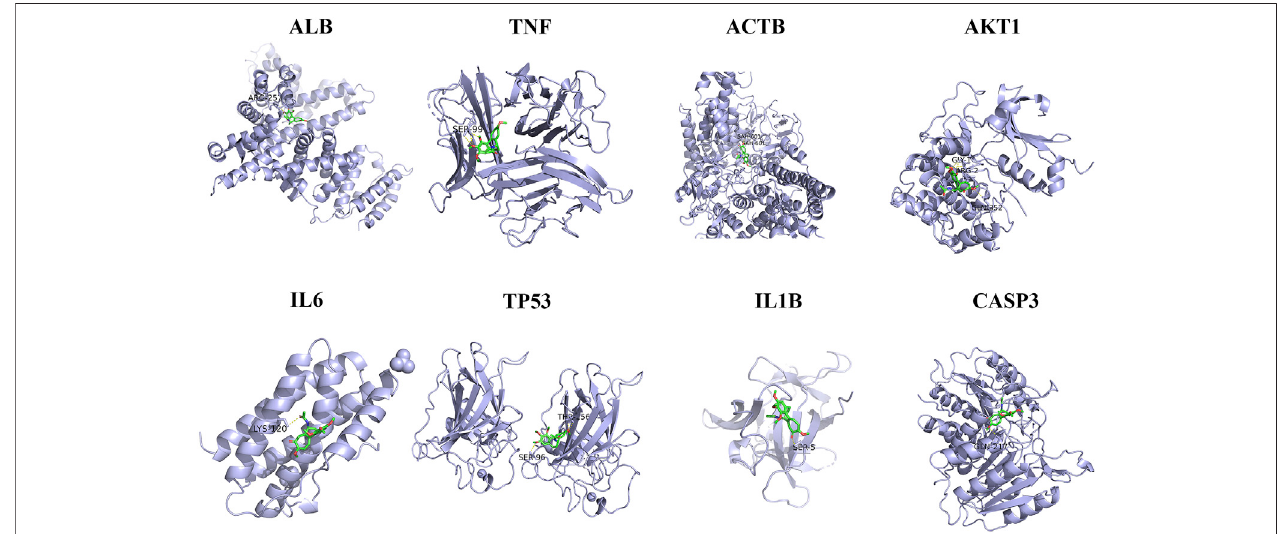
FIGURE 7 | Structural interactions of colchicine and key target receptors.